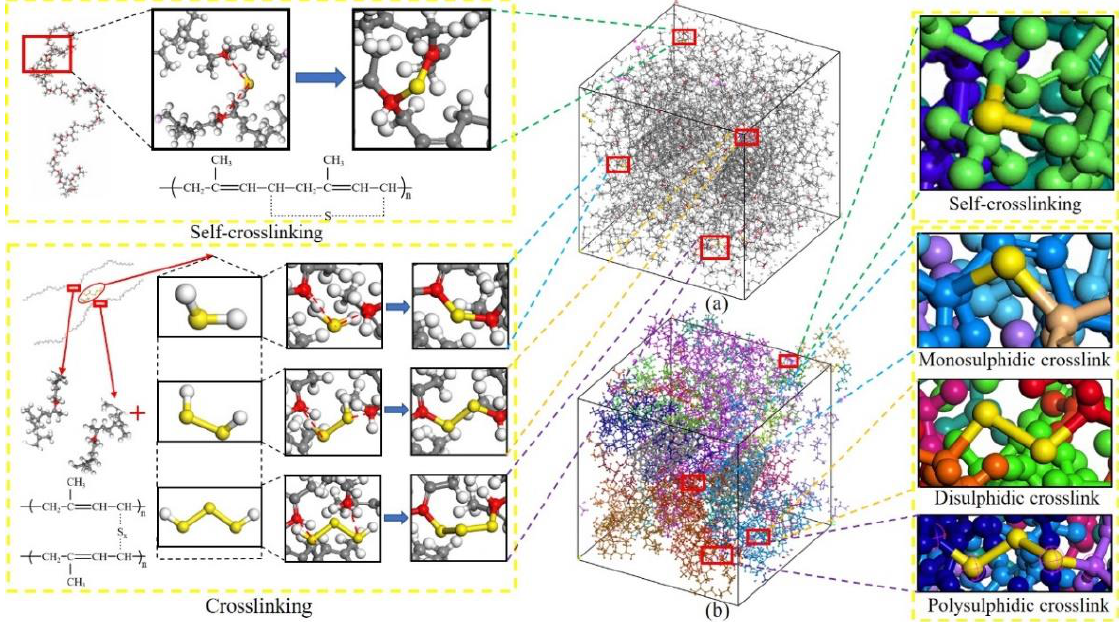
Figure 4. 10 wt.% CNT/VNR molecular model crosslinking process and containing crosslinking bonds. ( a ) Colored by atom types as same as Figure 2. ( b ) Colored by molecular chains.